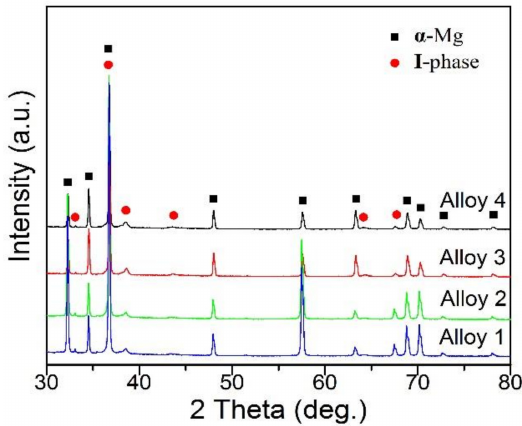
Figure 1. X-ray diffraction (XRD) patterns of experimental